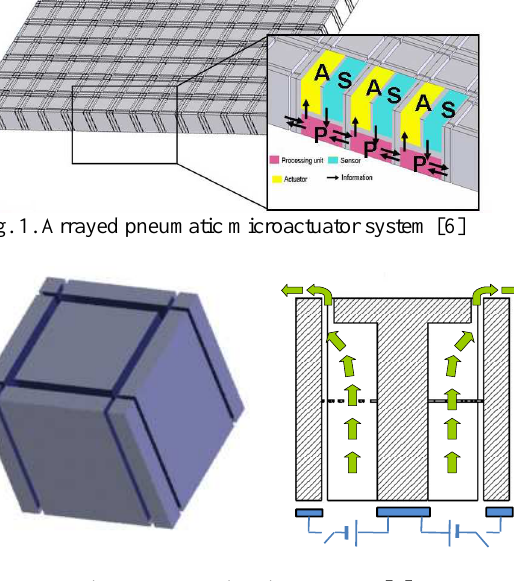
Fig. 2. Pneumatic microactuator [6]